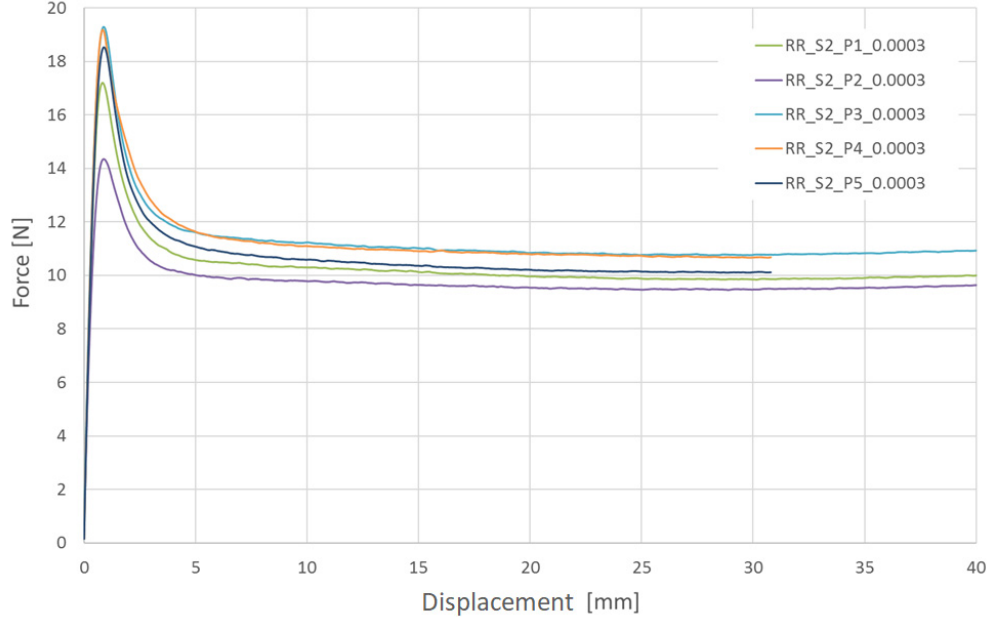
Figure 7. Longitudinal tensile force vs machine grip displacement for tubular specimens made of PLGA (assumed strain rate 0.0003 1/s).